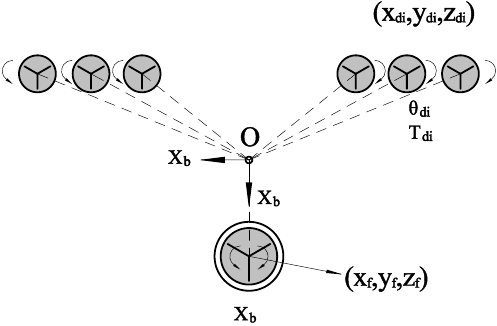
Figure 8. Force, moment, and some geometrical dimensions of UAV.